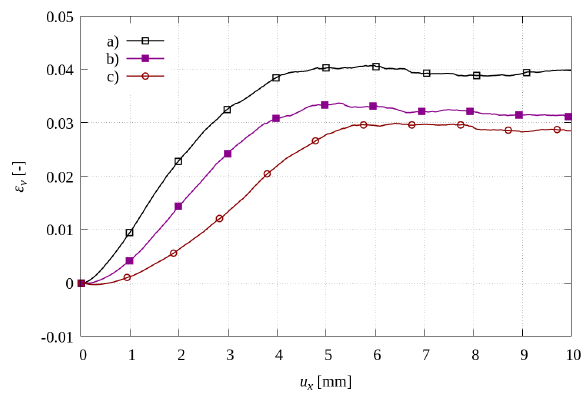
versus horizontal displacement u v = 200 kPa and c) σ 0